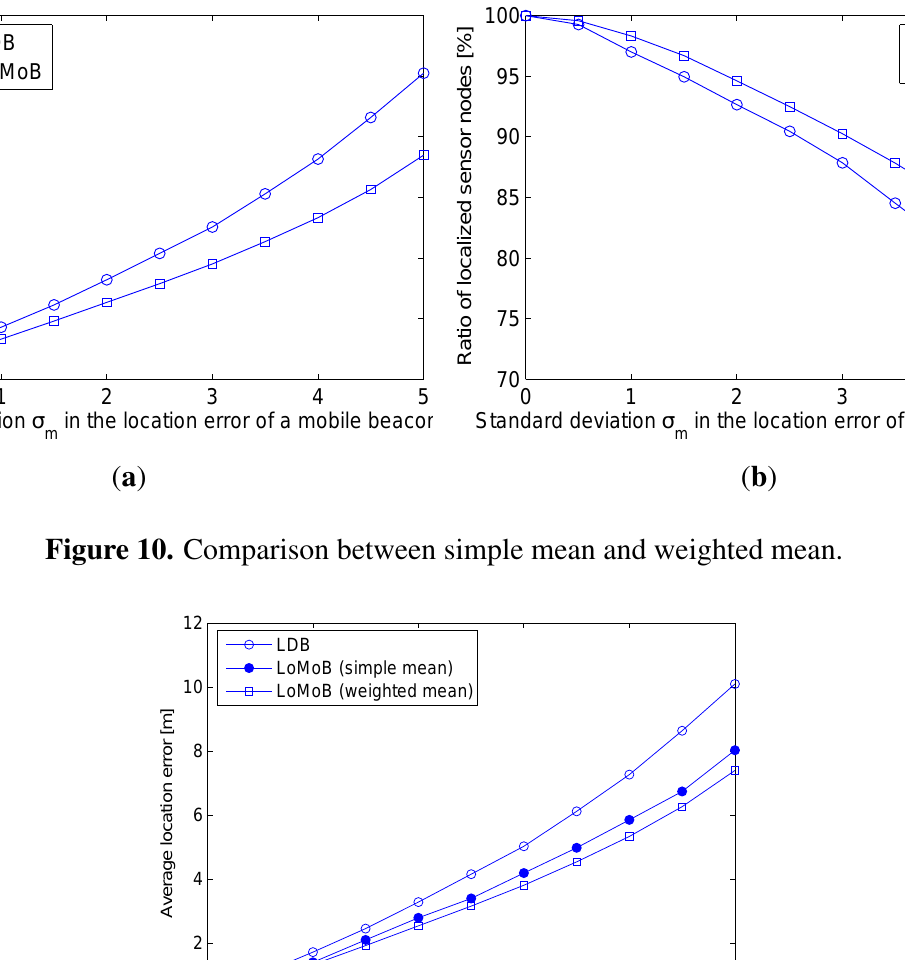
Figure 9. Localization accuracy as a function of standard deviation (cid:27) of a mobile beacon. ( a ) Average location error; ( b ) Ratio of localized sensor nodes.